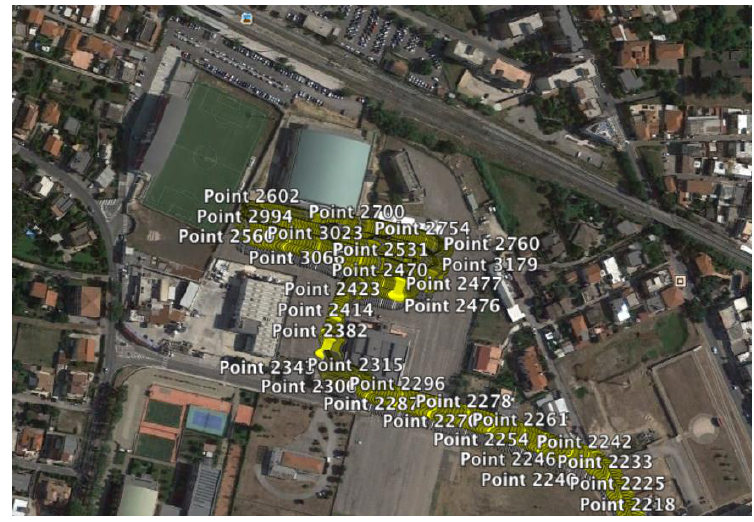
Figure 24. GPS tracking data log.